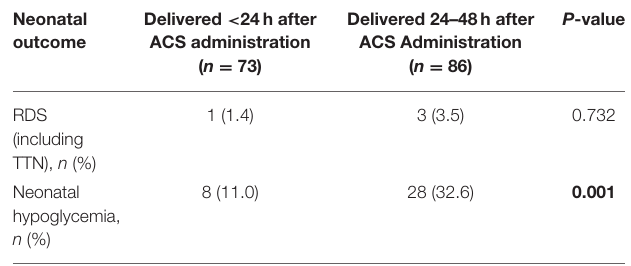
TABLE 6 | Comparison of neonatal outcomes between newborns delivered within 24h and those deliveries between 24 and 48h after early-term antenatal corticosteroid